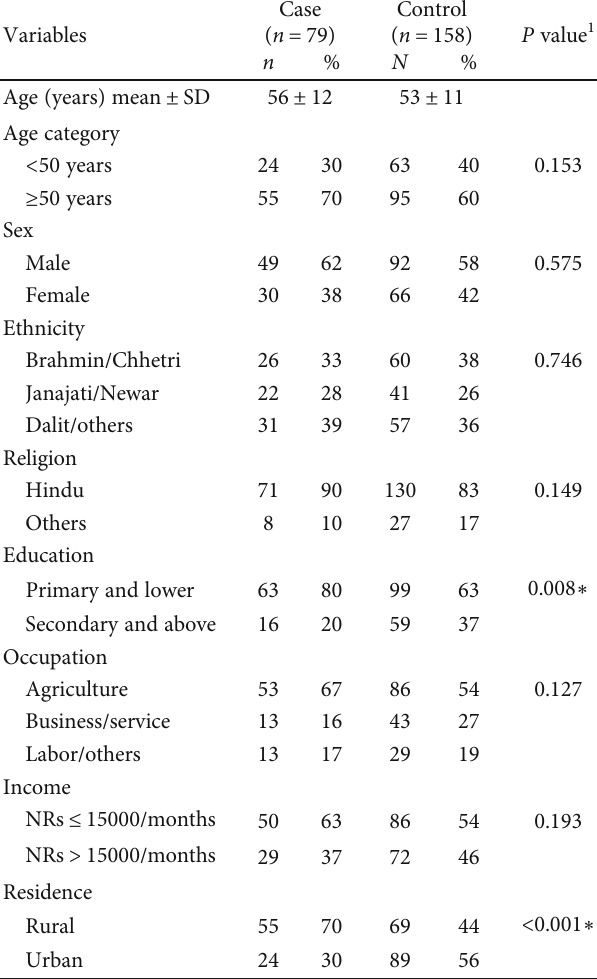
Table 1: Sociodemographic characteristics of the respondents.